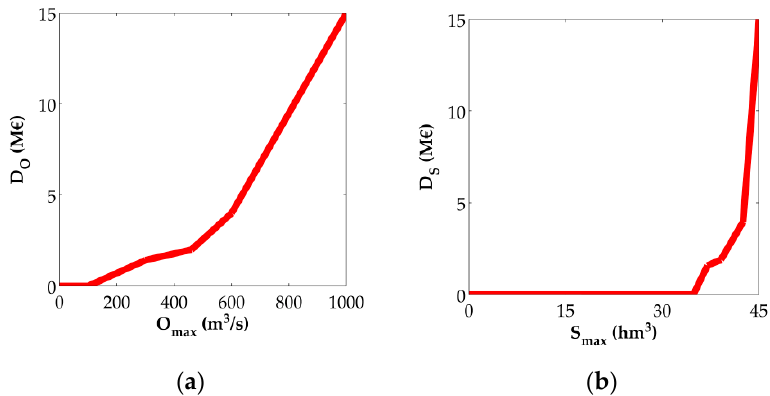
Figure 7. Damage curves due to ( a ) discharge flow and ( b ) storage volume of the Talave reservoir [21].